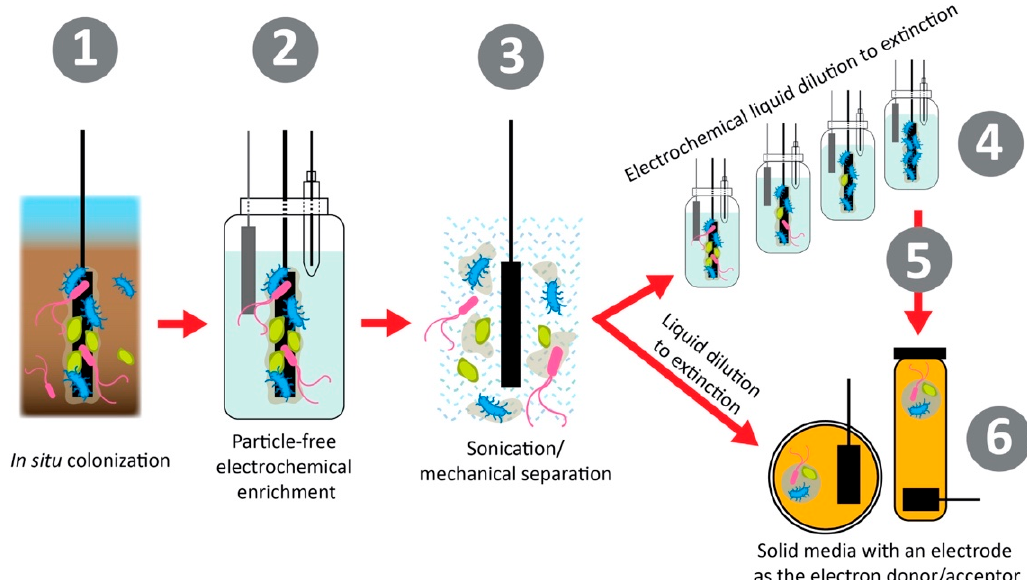
Figure 5. Isolating bacteria for electroactivity. First, the bacteria are colonized in situ. Then, using electrochemistry, the bacterial population is enriched around the electrode with strains capable of pairing their metabolism forming an electroactive biofilm. This biofilm is then separated from the electrode surface by sonication or other methods of mechanical separation. The microbial culture is then diluted in liquid or solid media to separate isolates from one another, eventually resulting in a single microbial isolate grown with the electrode surface as the sole electron acceptor or donor. Reproduced with permission from M.O. Yee, J. Deutzmann, A. Spormann, and A.E. Rotaru. Cultivating Electroactive Microbes, From Field to Batch. Nanotech. 2020, 31, 174,003 [13]. DOI: 10.1088/1361-6528/ab6ab5. Copyright 2020 IOP